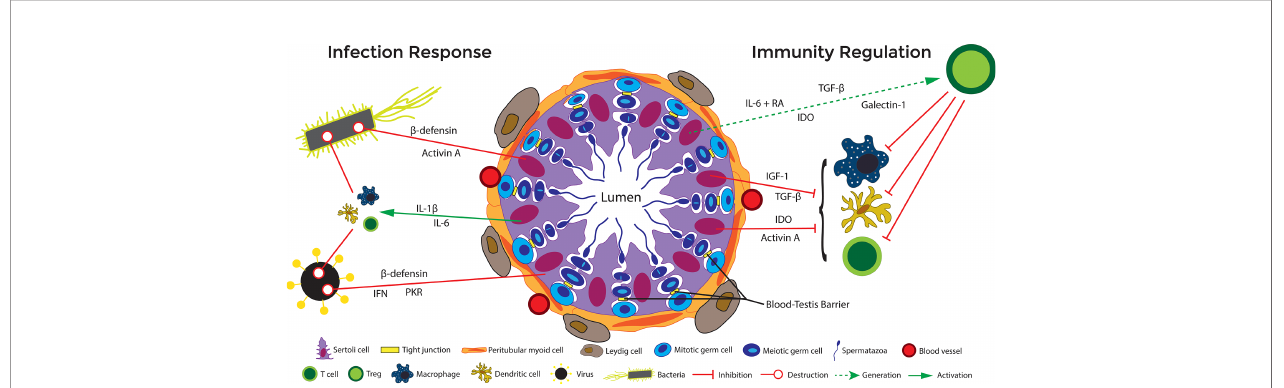
FIGURE 4 | Immune regulation in the testis. Under normal circumstances, cells in the testis (including Sertoli cells) produce immunoregulatory factors that favor the presence of regulatory immune cells, including M2 macrophages, Tregs, and tolerogenic dendritic cells, that maintain a milieu supporting germ cell survival. On the other hand, if bacteria and viruses invade the testis, to eliminate the pathogen, the testis can initiate an in fl ammatory response that includes activation of PRRs, production of in fl ammatory cytokines and antimicrobial factors, and recruitment and activation of in fl ammatory immune cells such as M1 macrophages and cytotoxic T cells. If this response to infection is kept in check it does not disrupt normal testicular function and the testis is able to maintains a delicate balance to promote spermatogenesis and prevent infection. However, if it gets out of control, in fl ammation in the testis can lead to disruption of the BTB and loss of germ cells. At the same time, if the response is not strong enough to eliminate the infection, it can lead to a sanctuary reservoir for viruses and bacteria. Solid red lines indicate inhibition and dashed green lines indicate potential (but not proven)